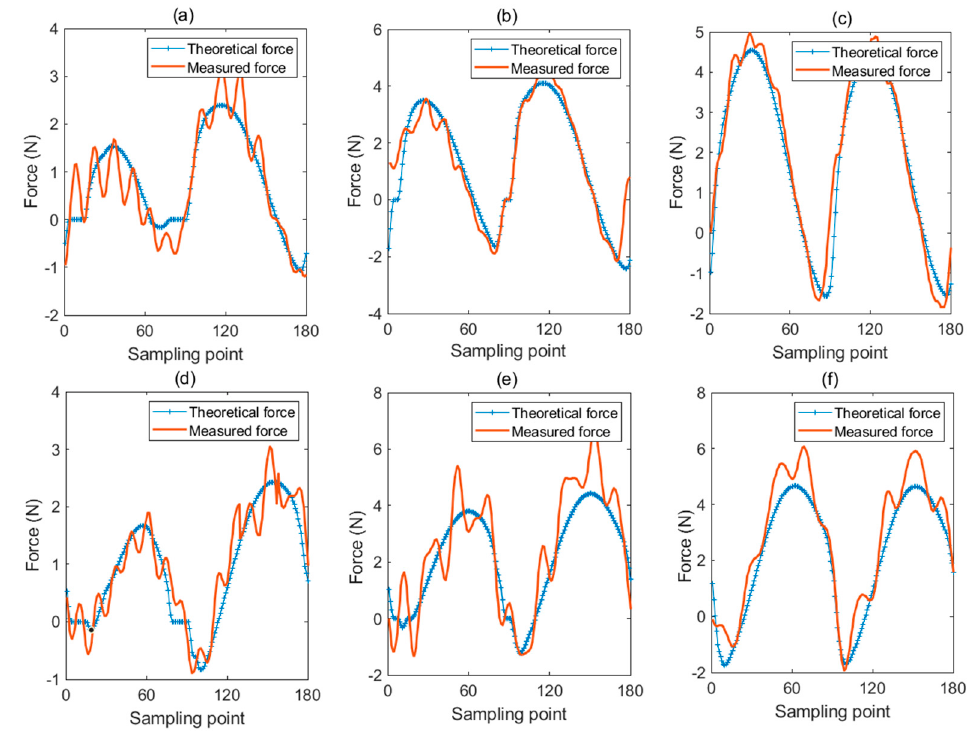
Figure 7. The predicted micro-milling force. ( a ) X-direction force of C1; ( b ) X-direction force of C2; ( c ) X-direction force of C3; ( d ) Y-direction force of C1; ( e ) Y-direction force of C2; ( f ) Y-direction force of C3.